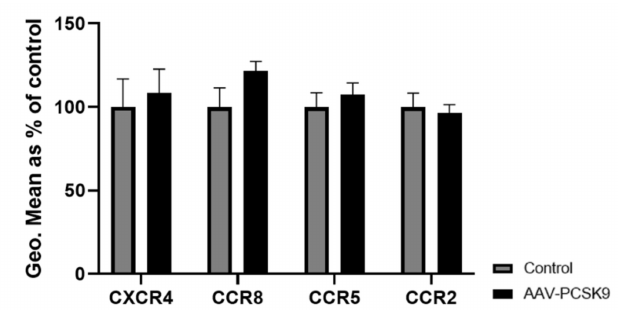
Figure 3. PCSK9 does not change the expression of chemokine receptors in peritoneal macrophages in vivo. The expression of chemokine receptors was measured using flow cytom- etry, represented using geometric mean (Geo.Mean) in peritoneal macrophages isolated from PCSK9 over-expressing mice ( n = 8) and compared to control mice ( n = 8). Bar graphs are representation of mean ± SEM. The statistical difference between the groups was calculated using 2-way ANOVA tests in GraphPad Prism.